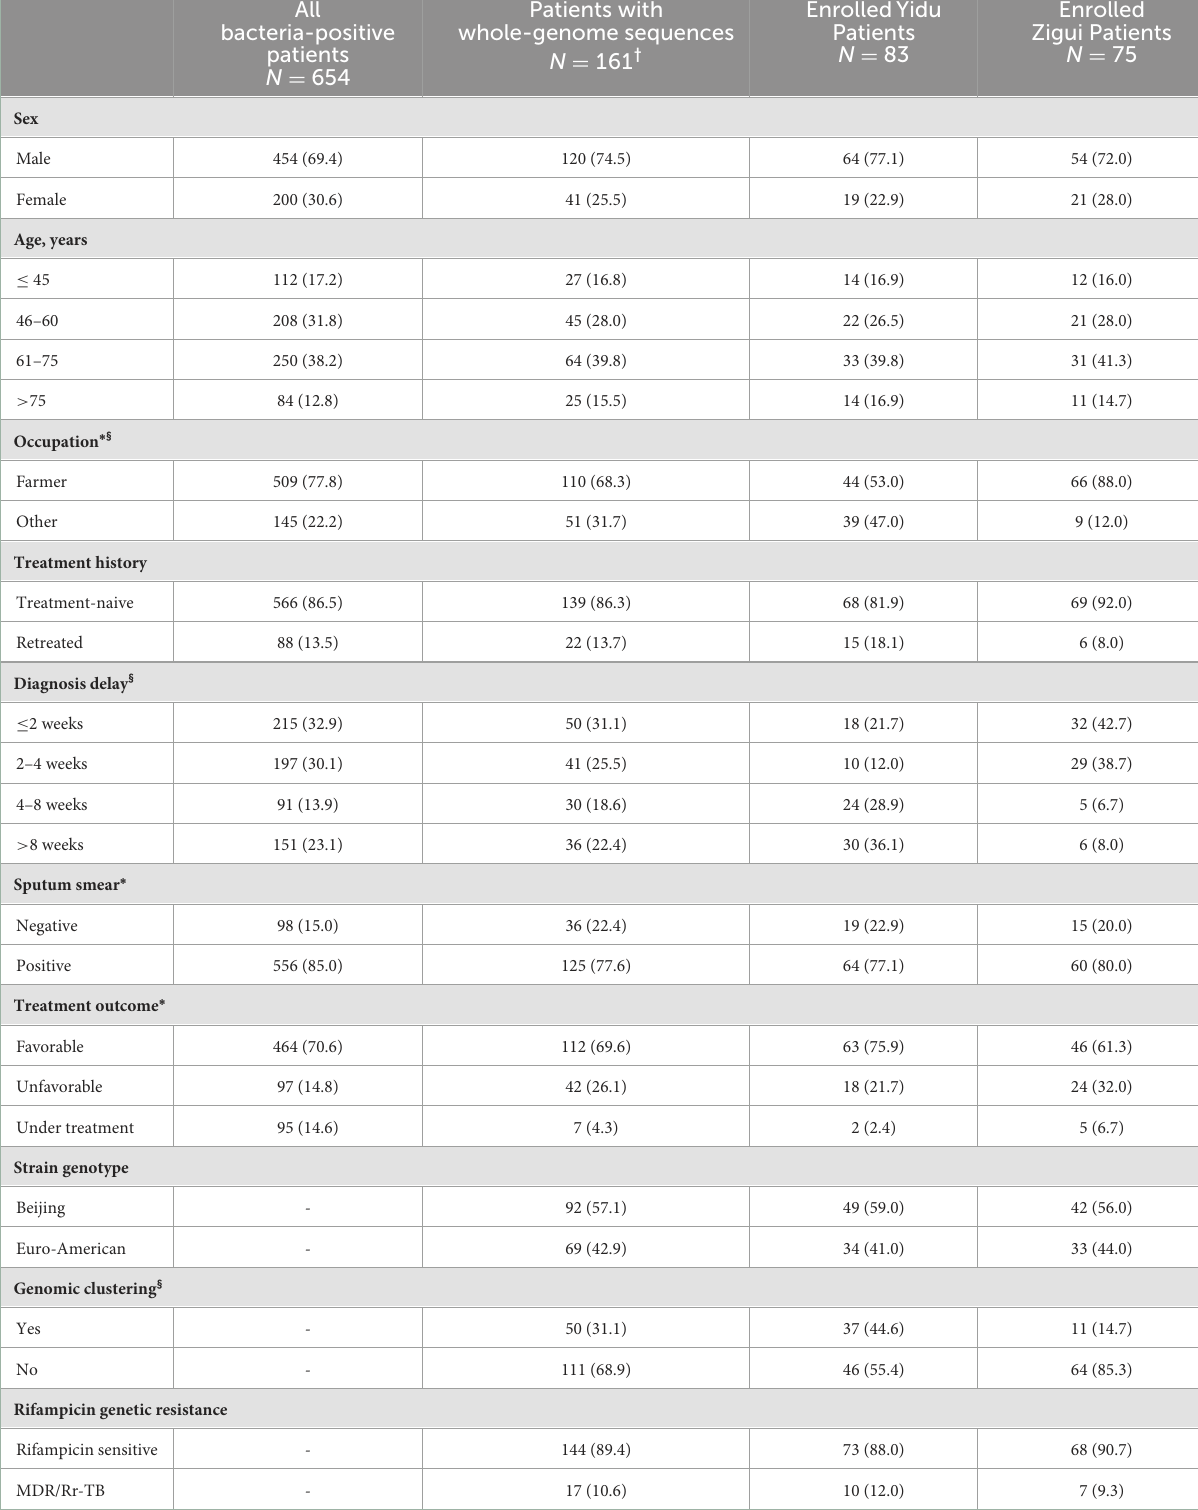
TABLE 1 Basic characteristics of tuberculosis patients during 2018–2020 in Yidu and Zigui,